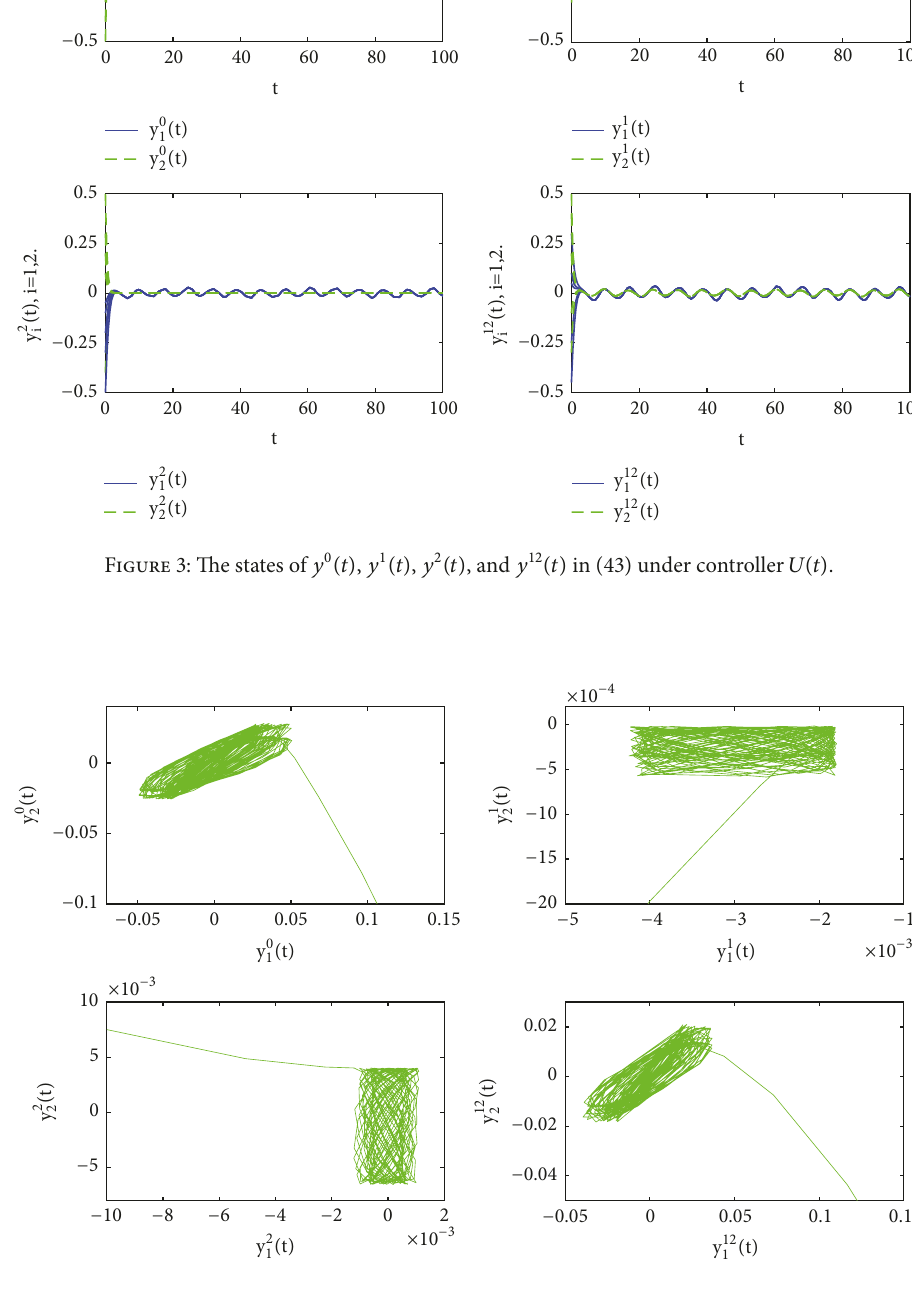
Figure 4: The states of four parts of 𝑦 1 (𝑡) and 𝑦 2 (𝑡) in 2-dimensional space under controller 𝑈(𝑡)